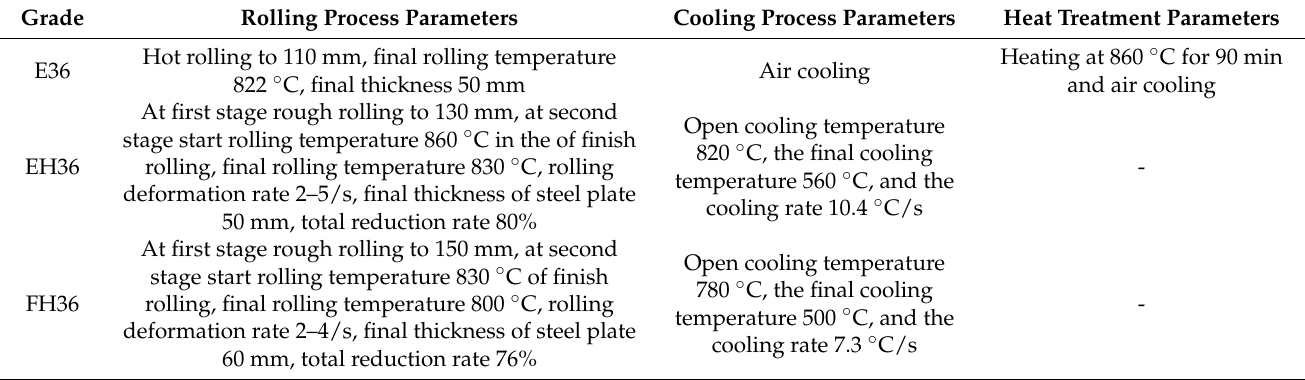
Table 2. Rolling, cooling, and heat treatment processes parameters of the three grades of ship plate steel. Grade Rolling Process Parameters Cooling Process